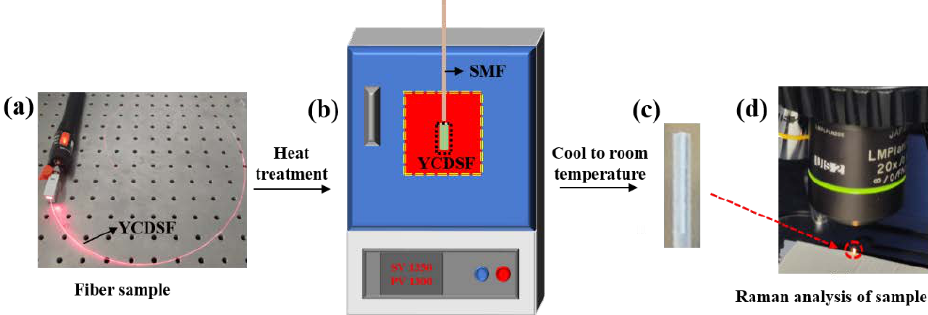
Figure 2. ( a ) Image of YCDSF transmission with red light. ( b ) Schematic diagram of YCDSF heat treatment. ( c) Image of YCDSF cooled to room temperature. ( d ) The Raman analysis of heat-treated YCDSF .